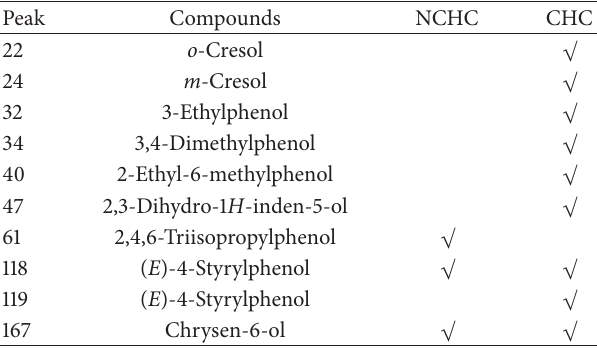
Table 3: Phenols detected in the reaction product from NCHC and CHC of